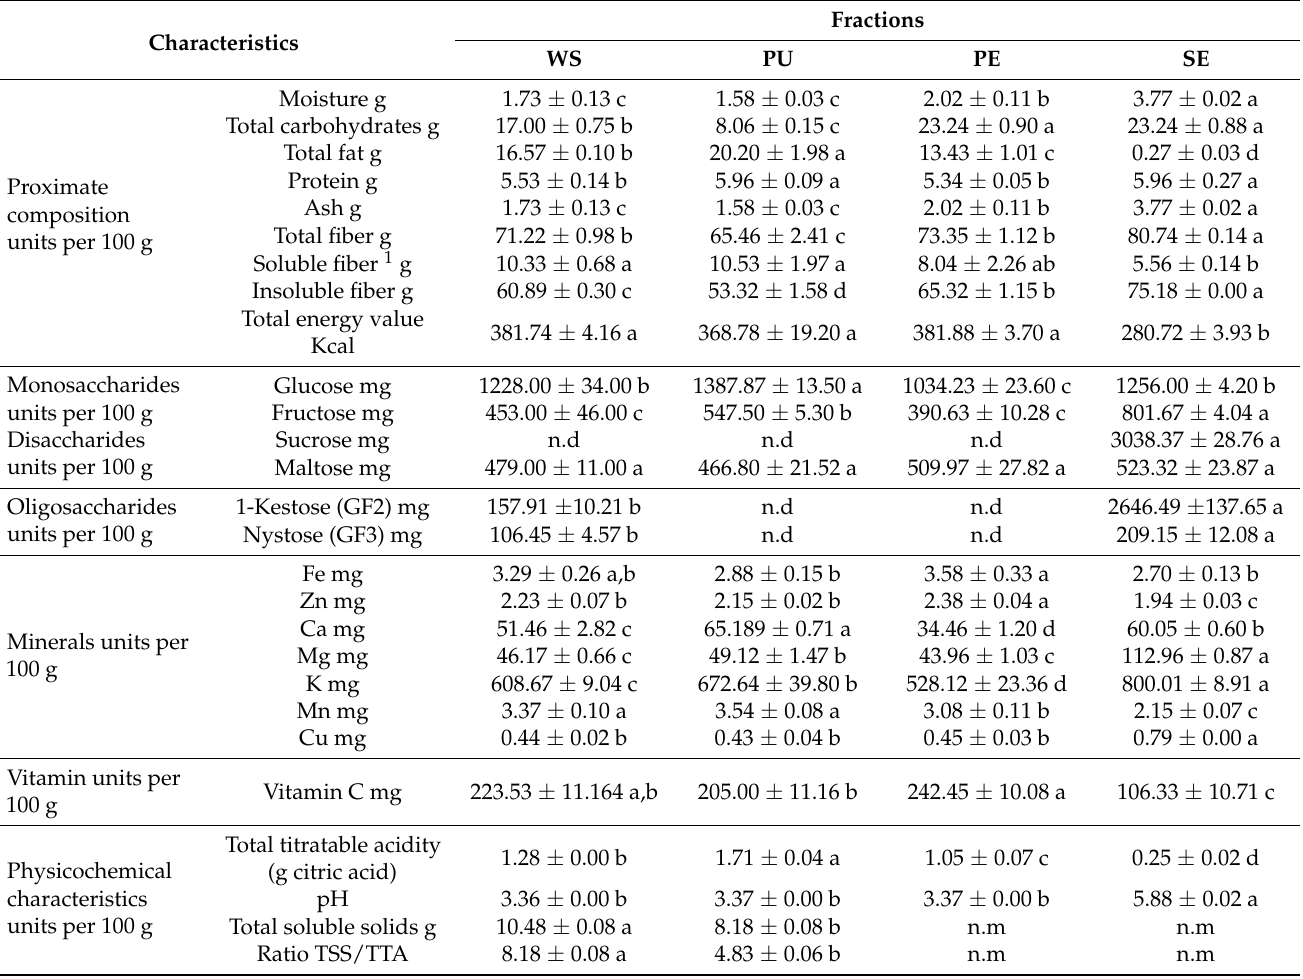
Table 2. Proximate composition, saccharides, minerals and vitamin C contents, and physicochemical characteristics of the buritirana fruit